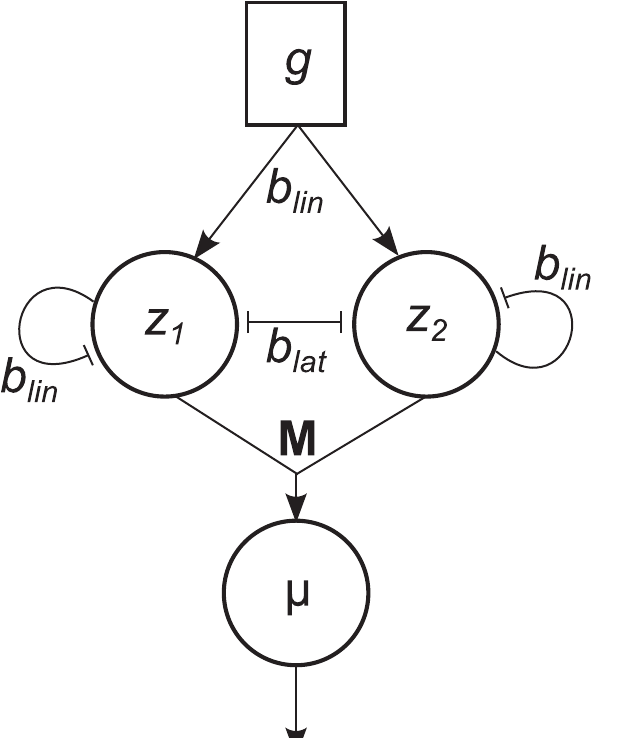
Fig 13. Network diagram for two-alternative Hopfield network (cf. Eqs 9, 10) with interpolated output that was used as generative model. The network is driven by constant input g modulated by self and lateral inhibition between state variables z 1 and z 2 . The strength of inhibition between state variables is determined by b lat (note that self-inhibition is not linear, but moderated by a sigmoid function σ ( z )) while the strength of self-inhibition and the strength of the constant input is controlled by b lin . After passing through another sigmoid function σ ( z ) the state variables interpolate target positions (cf. description of single dot task above) stored in M and consequently produce the (mean) prediction μ